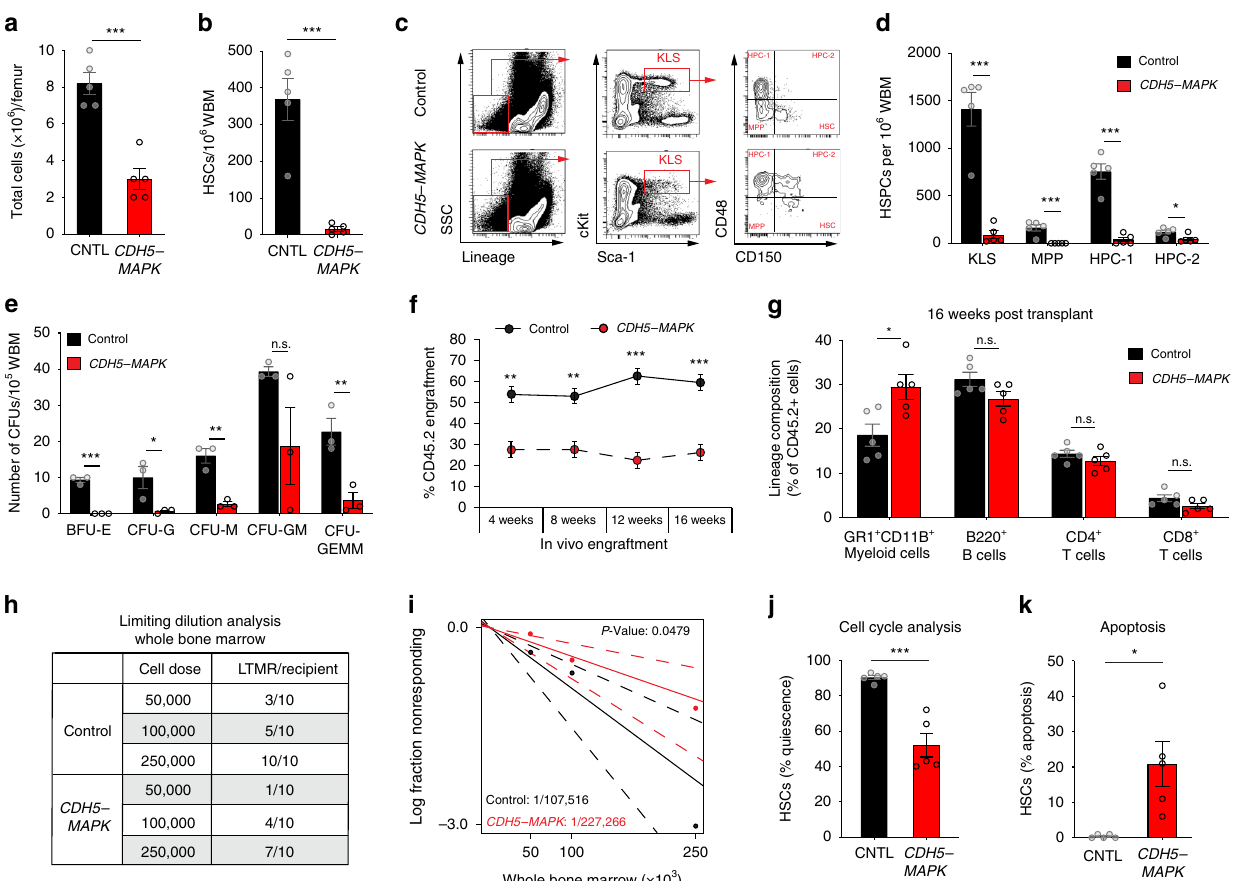
Fig. 1 CDH5-MAPK mice manifest HSC and hematopoietic defects. a Total cells per femur ( n = 5 mice/cohort). b Frequency of phenotypic HSCs per 10 6 femur cells assessed by fl ow cytometry ( n = 5 mice/cohort). c Representative contour plots demonstrating gating strategy for quanti fi cation of BM HSC and HSPC frequency by fl ow cytometry. d Frequency of phenotypic HSPCs per 10 6 femur cells assessed by fl ow cytometry ( n = 5 mice/cohort). e Methylcellulose-based progenitor assay. Bar graphs indicate number of CFUs per 10 5 WBM ( n = 3 mice/cohort). f , g Competitive repopulation assays assessing total CD45.2 + cell engraftment and CD45.2 + lineage distribution over 4 months ( n = 10 recipients/cohort; n = 5 donors/cohort). For evaluating competitive repopulation, 5 × 10 5 donor WBM cells (CD45.2) were transplanted with 5 × 10 5 competitor WBM cells (CD45.1) into pre-conditioned CD45.1 recipient mice. h Table representing the number of recipients that were positive for long term, multi-lineage reconstitution (LTMR) following whole-bone- marrow-limiting dilution transplantation assay ( n = 10 recipients/cohort per cell dose; n = 5 donors/cohort). i Line graph displaying estimates of HSC frequency in the indicated genotypes with dashed lines representing 95% con fi dence intervals. Stem cell frequency and signi fi cance were determined using Extreme Limiting Dilution Analysis (ELDA). j Cell-cycle analysis of HSCs in the indicated genotypes by fl ow cytometry ( n = 5 mice/cohort). Gating strategy described in Supplementary Fig. 1b. k Quanti fi cation of HSC apoptosis in the indicated genotypes by fl ow cytometry ( n = 5 mice/cohort). Gating strategy described in Supplementary Fig. 1b. Error bars represent sample mean ± SEM. Statistical signi fi cance was determined using two-tailed unpaired Student ’ s t -test. * P ≤ 0.05; ** P < 0.01; *** P < 0.001; n.s. P > the IkB-SS transgene is selectively expressed within ECs of adult mice 39 . Analysis of NF- κ B regulated target gene expression within in vivo BMECs (de fi ned as CD45-Ter119-CD31 + VEcadherin + ) NF- κ B signaling within ECs of CDH5-MAPK mice is suf fi cient to of CDH5-MAPK mice revealed increased levels of NF-kB sig- restore their vascular defects. To this end, we transduced BMECs naling targets, including the pro-in fl ammatory cytokines and derived from control and CDH5-MAPK mice with a lentivirus expressing a dominant negative I κ B α S32A/S36A super-suppressor (IkB-SS) construct that sequesters NF-kB (p65/p50) in the Supplementary Table 2). Importantly, BMECs derived from cytoplasm 37,38 . Immunoblot analysis con fi rmed the expression of CDH5-MAPK::IkB mice demonstrated an overall decrease in IkB-SS transgene and revealed no signi fi cant alterations in ERK1/ expression of NF-kB target genes indicating that IkB-SS transgene 2 or p65 phosphorylation levels due to transgene expression expression within BMECs of CDH5-MAPK mice decreased their (Fig. 3a, b). Immuno fl uorescence analysis con fi rmed that NF- κ B signaling (Fig. 3e – f, Supplementary Table 2). Further- expression of IkB-SS decreased p65 nuclear translocation in more, immuno fl uorescence analysis of the BM endothelial niche BMECs of CDH5-MAPK mice (Fig. 3c, d). These fi ndings sug- demonstrated a normalization of the vascular dilation in CDH5- gested that increased NF- κ B signaling within ECs of CDH5- MAPK::IkB mice, con fi rming that inhibition of endothelial NF- κ B MAPK mice in vivo could be suppressed by EC-speci fi c expres- signaling is suf fi cient to restore BM vascular integrity in CDH5- sion of IkB-SS. To test this hypothesis, we crossed CDH5-MAPK MAPK mice (Fig. 3g). Collectively, these fi ndings con fi rmed that mice with Tie2.IkB-SS mice ( CDH5-MAPK::IkB mice) wherein the detrimental effects of endothelial MAPK activation on the BM